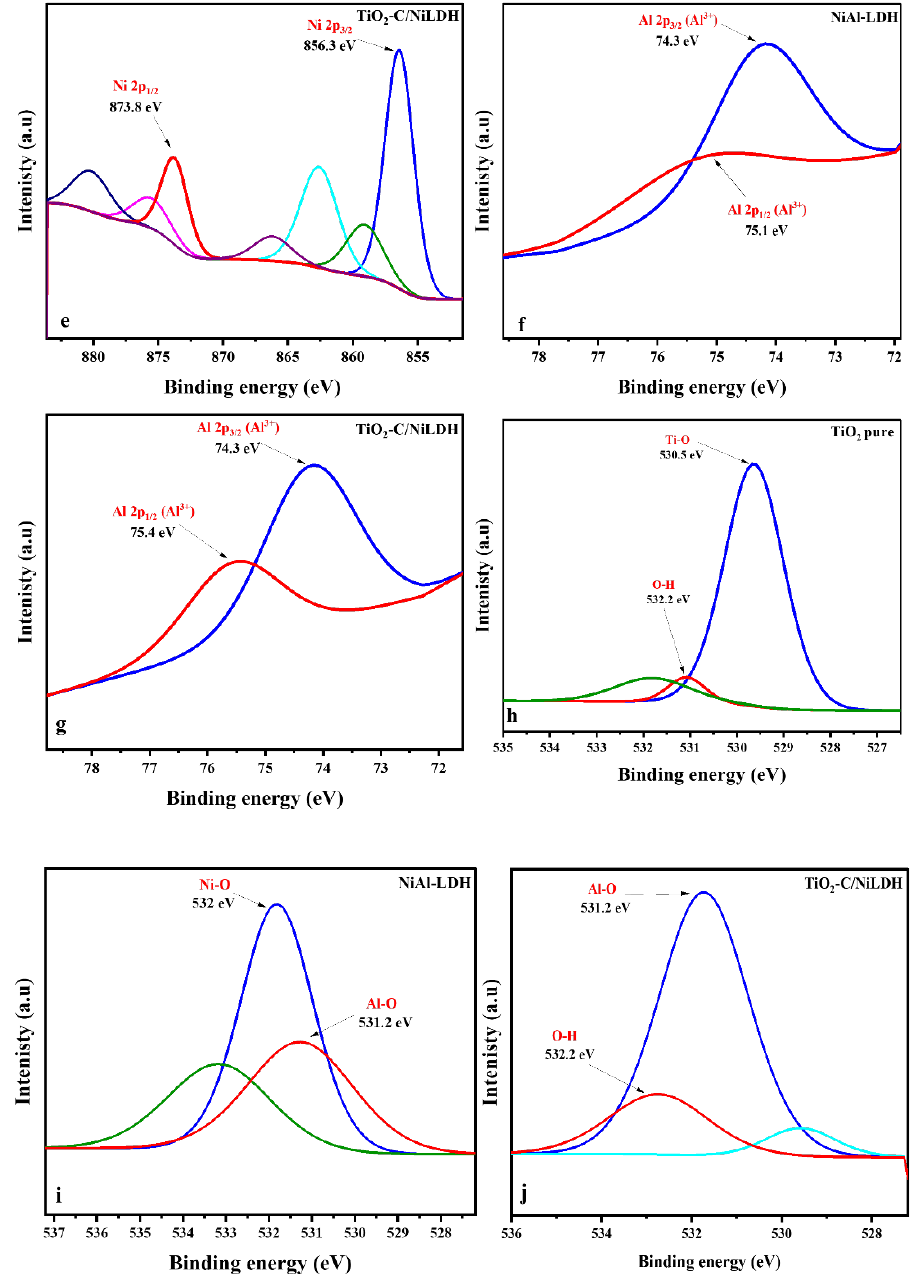
Figure 3. Deconvoluted XPS spectra of TiO 2 , TiO 2 -C, NiAl-LDH, and amalgamated TiO 2 -C/NiLDH samples. ( a , f ) Ti 2p, ( d , g ) Ni 2p, ( c , h ) Al 2p, and ( b , e , i , j ) O 1s.